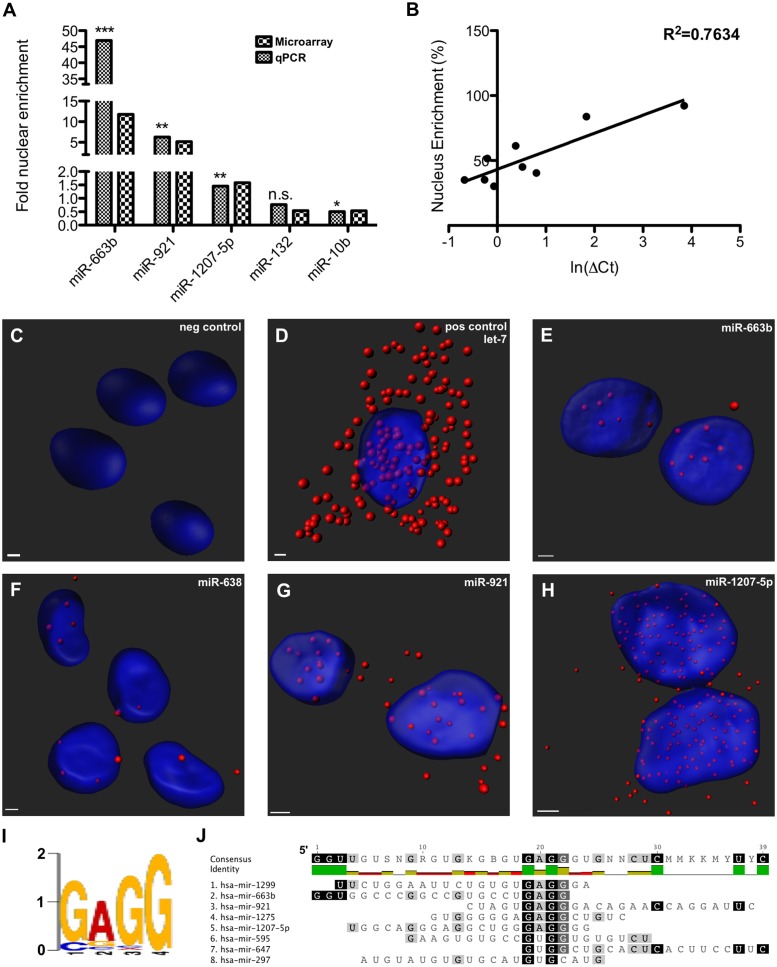
Nucleus-enriched mature microRNA (miRNA) share a common motif. (A) Nucleus enrichment of human miRNAs was measured by microarray and confirmed by qPCR. Asterisks indicate significance of the difference between nuclear and cytoplasmic expression (∗p < 0.05; ∗∗p < 0.01; ∗∗∗p < 0.0001). Note the split y-axes. (B) A strong correlation observed between raw % nuclear enrichment and Ct value served to validate the analysis. (C–H) miRNA FISH detection of nuclear miRNA enrichment. Z-stack confocal images, taken at 63X magnification with oil-immersion on a Zeiss LSM800, were rendered with Imaris software. (I)
De novo motif detected among nucleus-enriched mature miRNA. (J) Alignment showing position of motif in miRNA sequence.